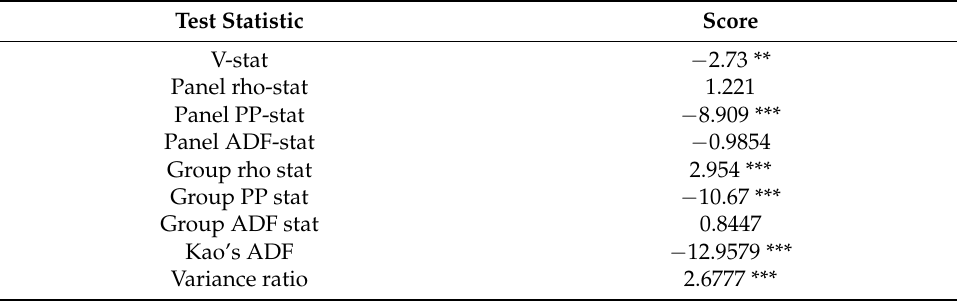
Table 4. Pedroni’s panel cointegration.